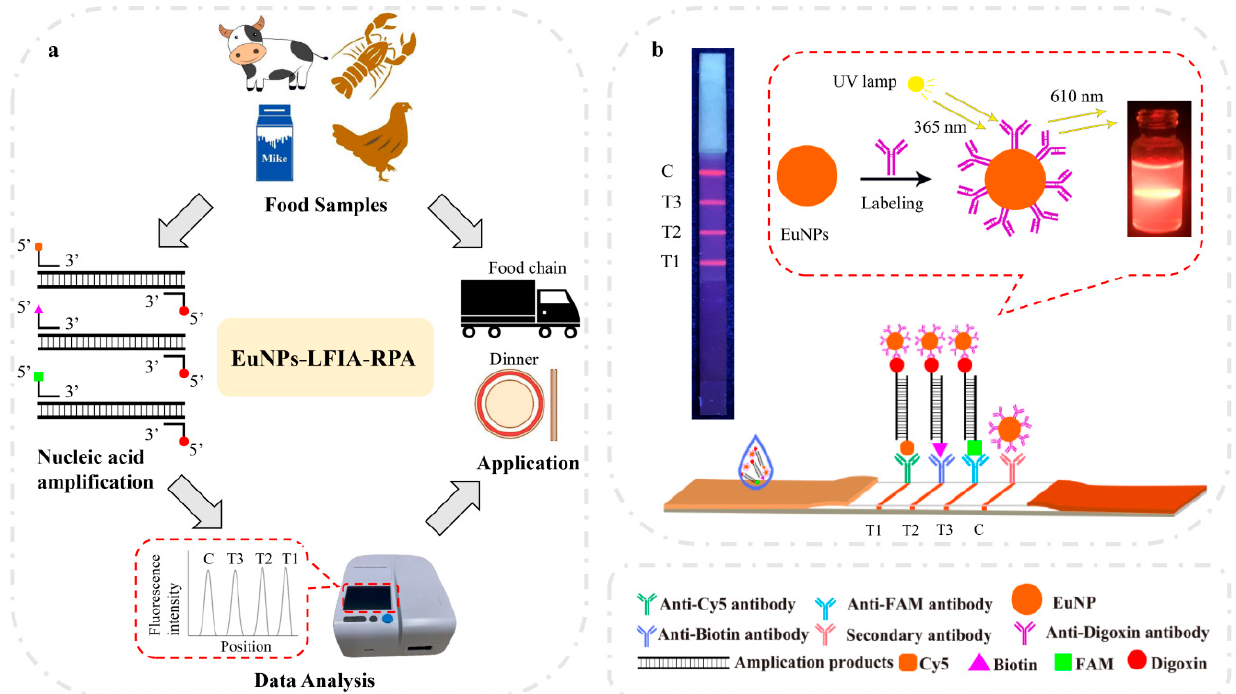
Figure 1. Schematic of EuNP-based LFIA–RPA. The application ( a ) and working principle ( b ) of the EuNP-based recombinase polymerase amplification combined with lateral flow immunoassay (EuNP-based LFIA–RPA).